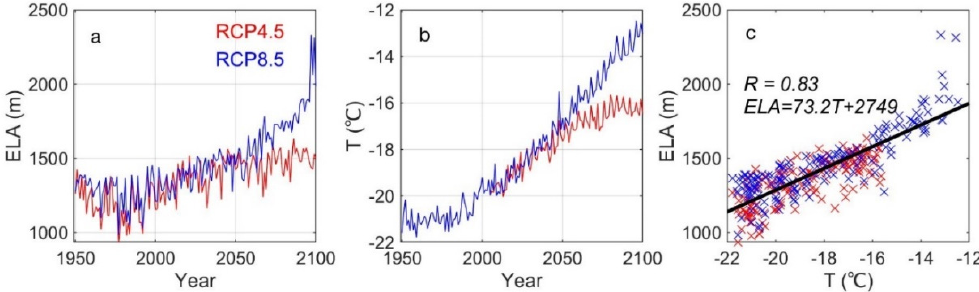
Figure 5. ( a ) Modeled annual mean ELAs averaged the whole GrIS by SEMIC during 1950–2100; ( b ) bias-corrected and downscaled ensemble mean near-surface air temperature over the GrIS during 1950–2100; ( c ) ELA versus near-surface air temperature (crosses) and linear fit (black line) under RCP4.5 (red crosses) and RCP8.5 (blue crosses).